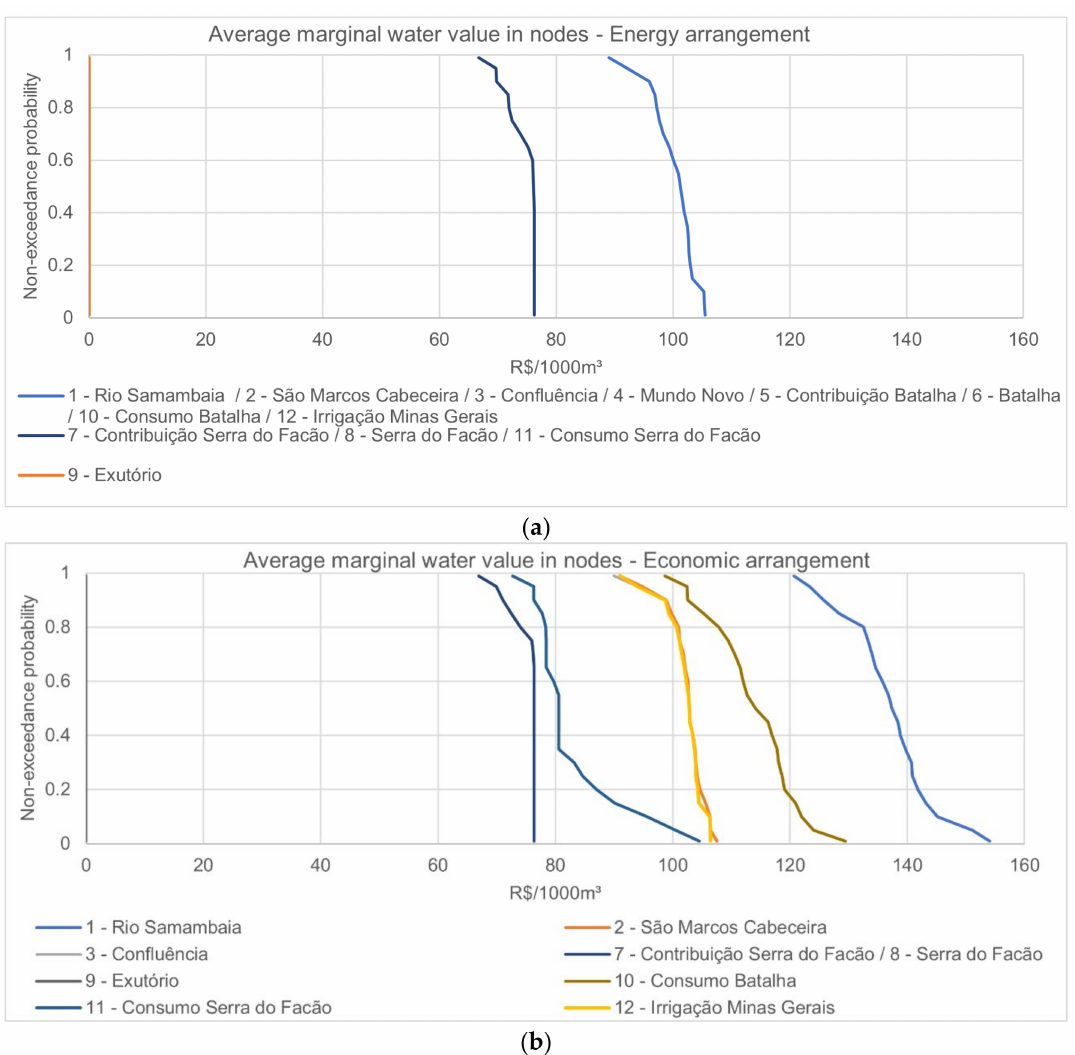
Figure 10. Non-exceedance probability curves of average marginal values in the energy arrangement ( a ) and economic arrangement ( b